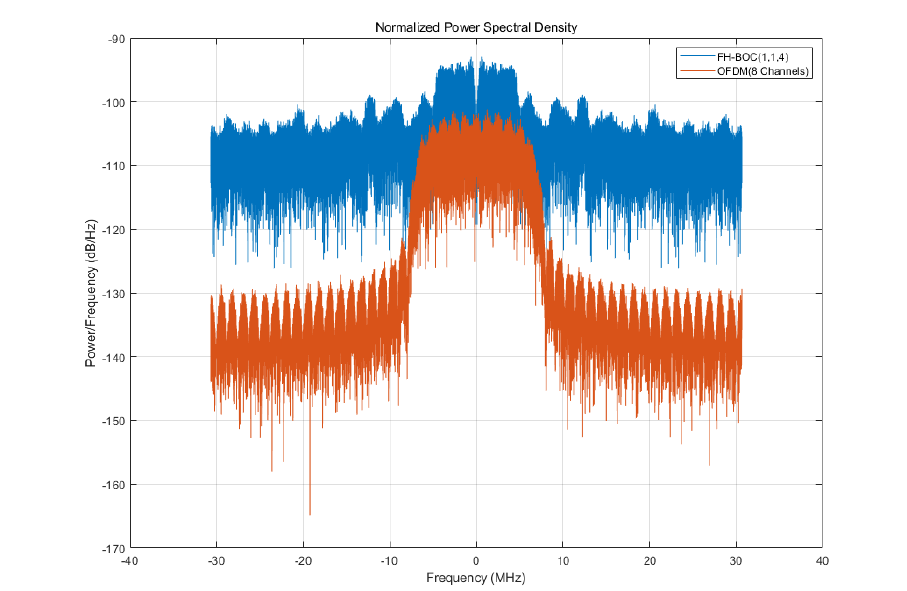
Figure 13. Power spectral density distribution of combined